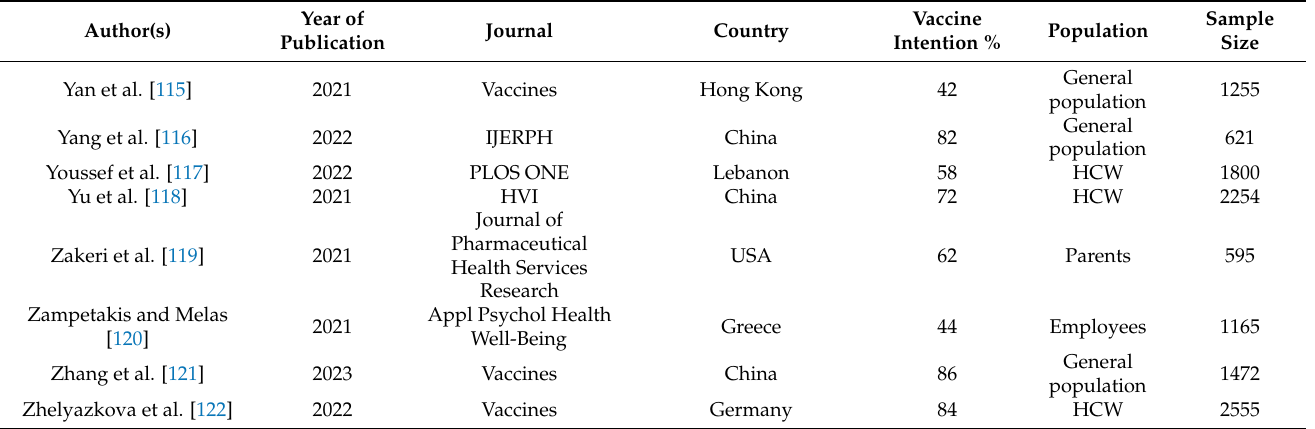
3.2. Vaccination Intention Rate by Country, Population, and Year Overall COVID-19 vaccination intention rate was 68.19% (Std. = 17.58), which ranged from 31% to 97.6%. Average vaccination intention percentages for COVID-19 by country were: Malaysia (94.3%), India (89.3%), Puerto Rico (82.7%), Philippines (77.50%), China (76.34%), Israel (75.72%), UK (74.23%), Vietnam (73.48%), Bangladesh (73.17%), Saudi